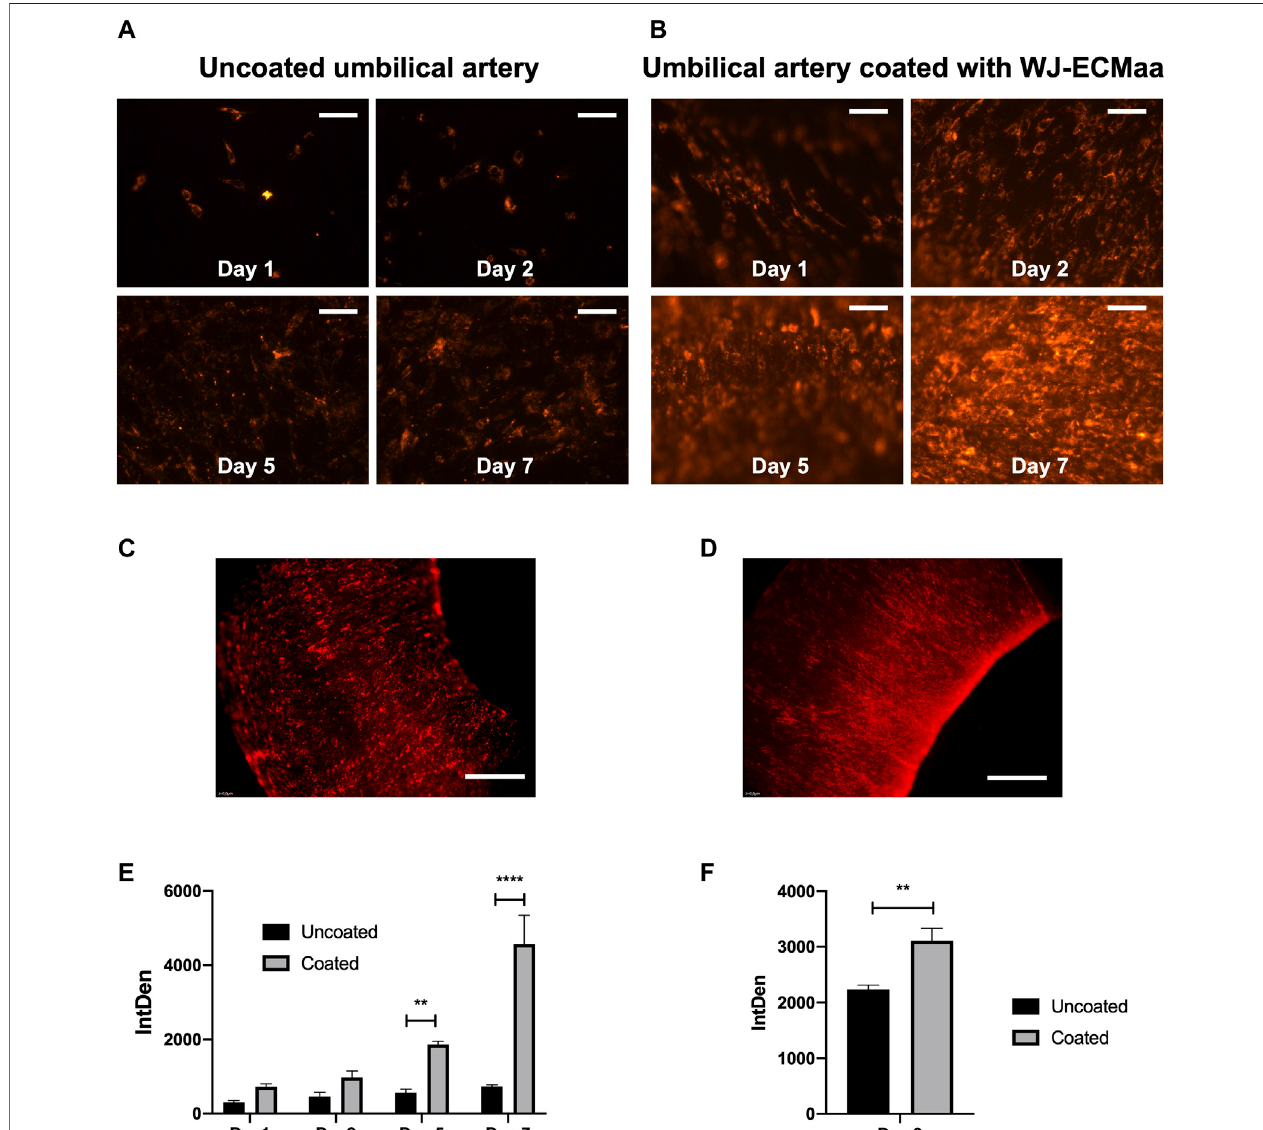
FIGURE7| EvaluationofWJ-ECMaacoatingimpact onthecellularizationprocess.Epi fl uorescenceobservationsatdays1,2,5and7ofWJ-MSClabelled withDiI on uncoated (A) and previously coated (B) umbilical artery luminal surface (Scale bars, 500 µm). Epi fl uorescence Macroscopic observations at day 9 of both uncoated (C) and coated (D) segments (Scale bars, 1 mm). Comparison of integrated density at days 1, 2, 5, 7 (E) and day 9 (F) on uncoated and WJ-ECM coated segments. Results are presented as the mean ± SEM for each condition, and were statistically analyzed following two-way ANOVA ( p -value: ** < 0.01, *** < 0.0001); n =